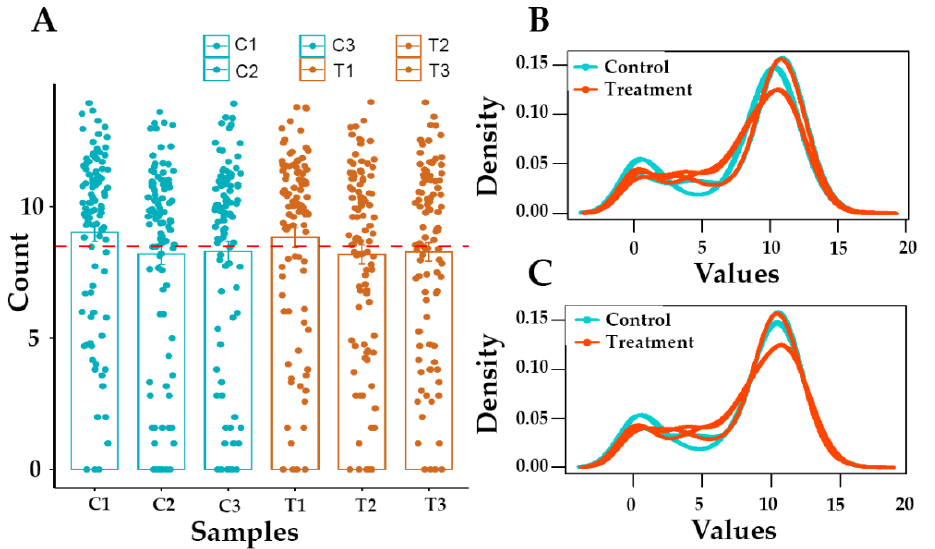
Figure 2. Distribution of gene counts. As shown in bar plot ( A ), more than 8 million reads are produced for each sample. According to density plot, raw read Counts (log2 (counts + 1)) are not non-normalized distributed ( B ). The density plot of normalized count (log2 (normalized counts)) per sample is shown in plot ( C ). C1-3: controls; T1-3: Treated cells with Gemini-Cur .